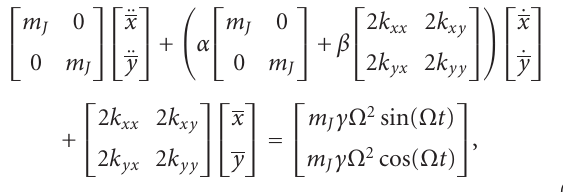
located at the left end, node two 0.5 meter from the left end and node three 1.0 meter from the left end.